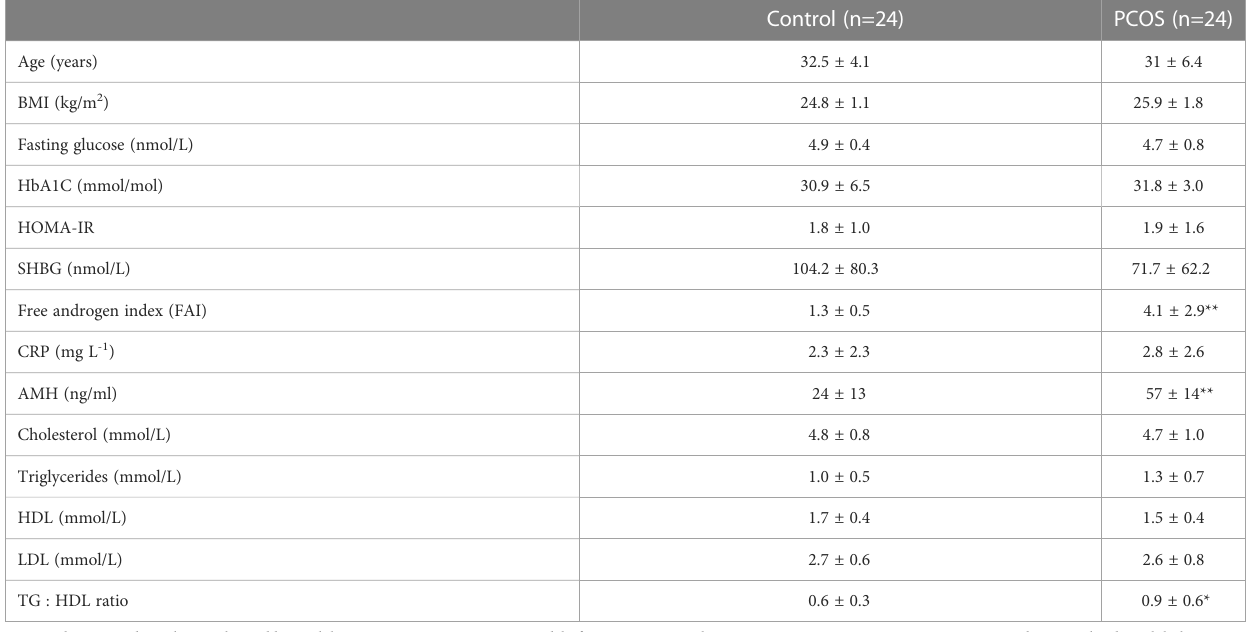
TABLE 1 Demographics, baseline, hormonal and metabolic parameters of the PCOS subjects and controls (mean ± SD), *p<0.05,